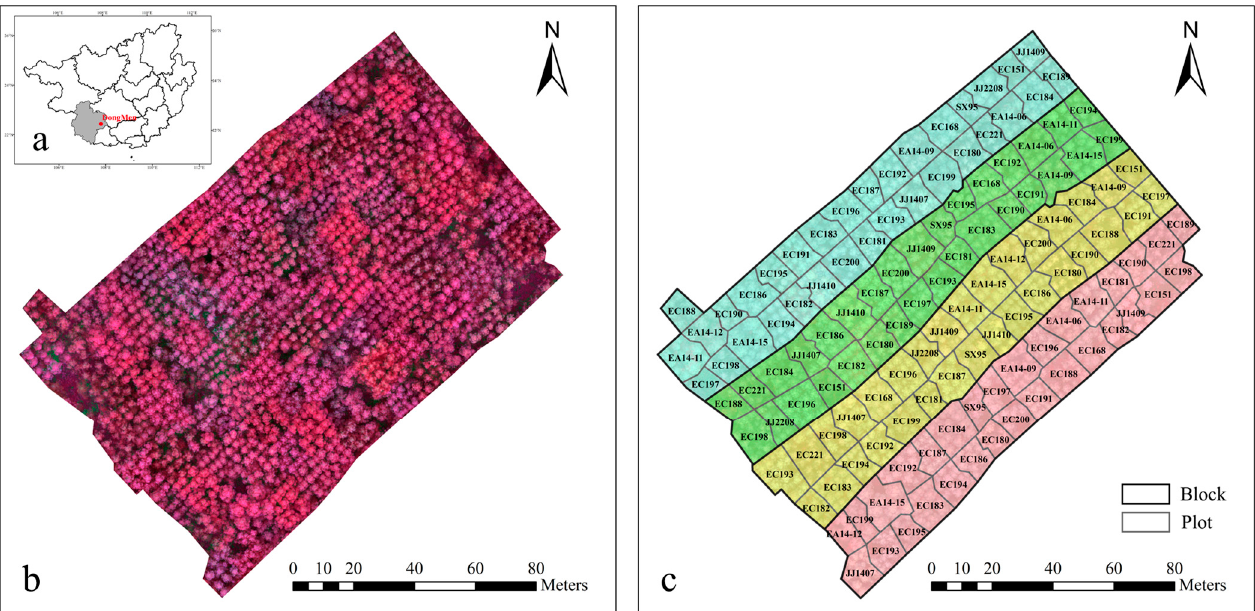
Figure 2. Geographical location, orthophoto and clonal plot division of eucalypt clones. ( a ) The geographical location of the study site in Guangxi Zhuang Autonomous Region; ( b ) false color synthesis orthophoto of the study site; ( c ) combined with the local background data of the study site, the boundary of specific blocks (black lines) and clonal plots (gray lines) were divided, and the 4 blocks were displayed in different colors.